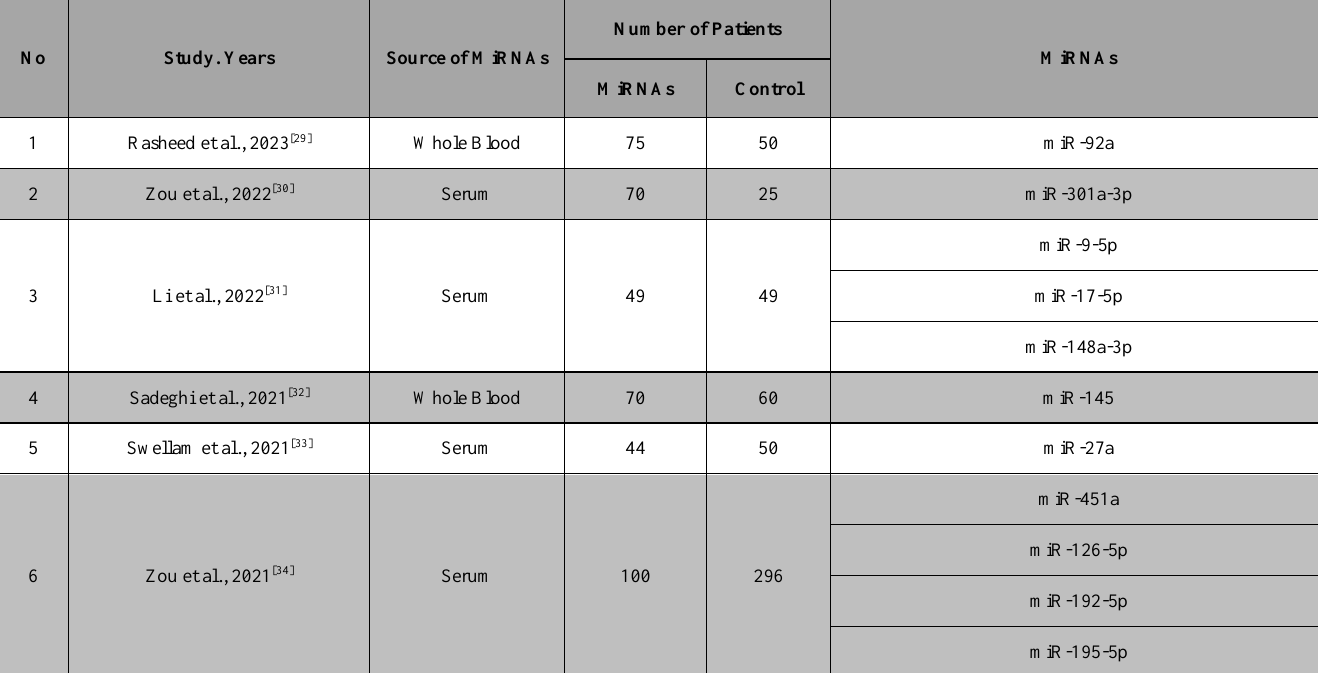
Table 2. Demographic information extracted from the full text of the selected